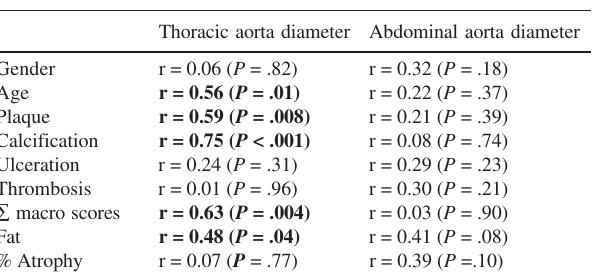
Table 3 - Linear correlation (univariate analysis) of the diameters of the thoracic and abdominal segments of the aorta, gender, age, and scores attributed to morphologic